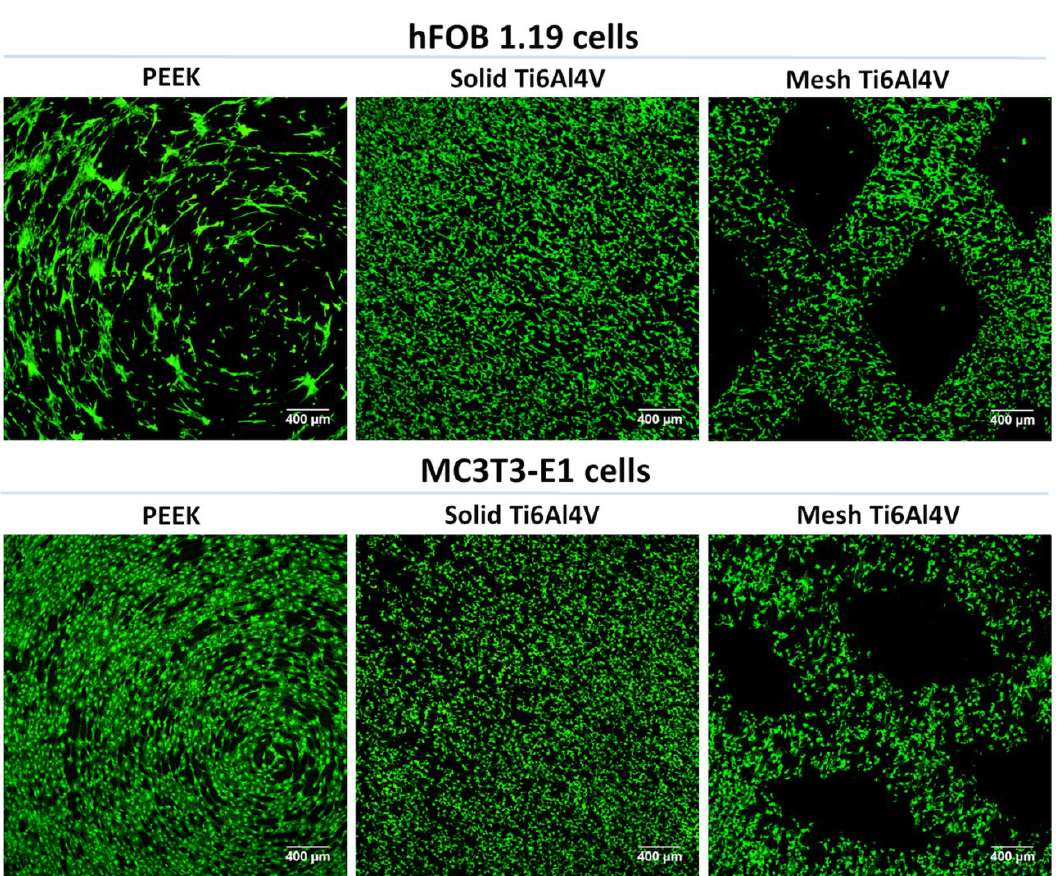
Figure 5. CLSM images presenting viability of osteoblasts cultured for 48 h on the surface of tested materials (green fluorescence—viable cells stained with calcein-AM; magnification 40×, scale bar = 400 μm).